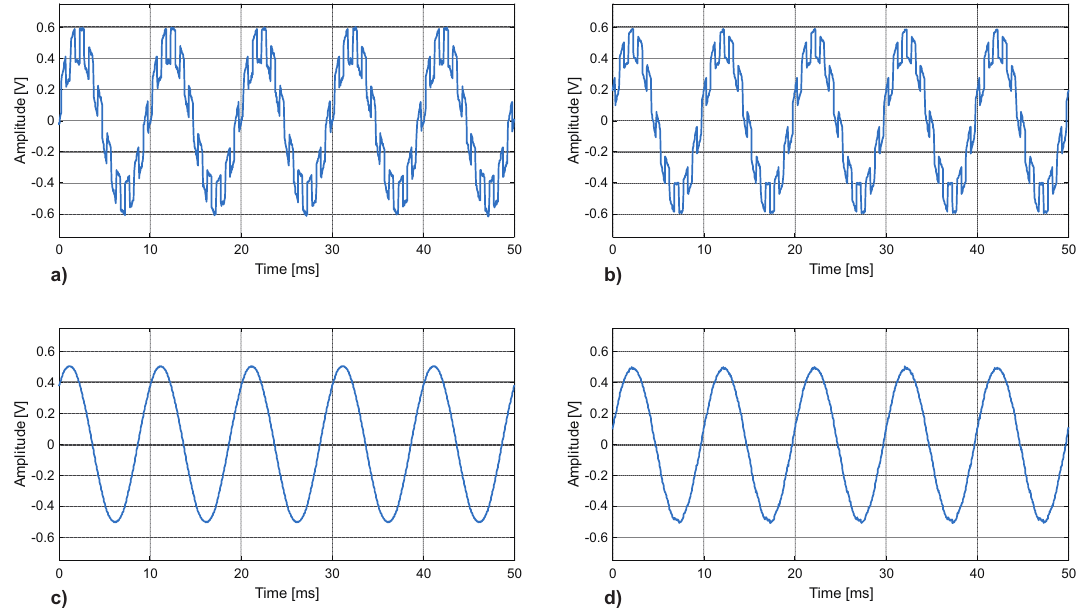
Figure 11. Time-domain waveform of the acquired signals under 9dBm AM EMI excitation: ( a ) OPA2277 opamp output voltage with EMI injection; ( b ) MCP6V02 opamp output voltage with EMI injection; ( c ) nominal input signal spectrum as in Figure 8b; ( d ) Output voltage with EMI injection estimated starting from the EMI corrupted waveforms in ( a , b ), by the proposed EMI-induced errors suppression procedure with α =